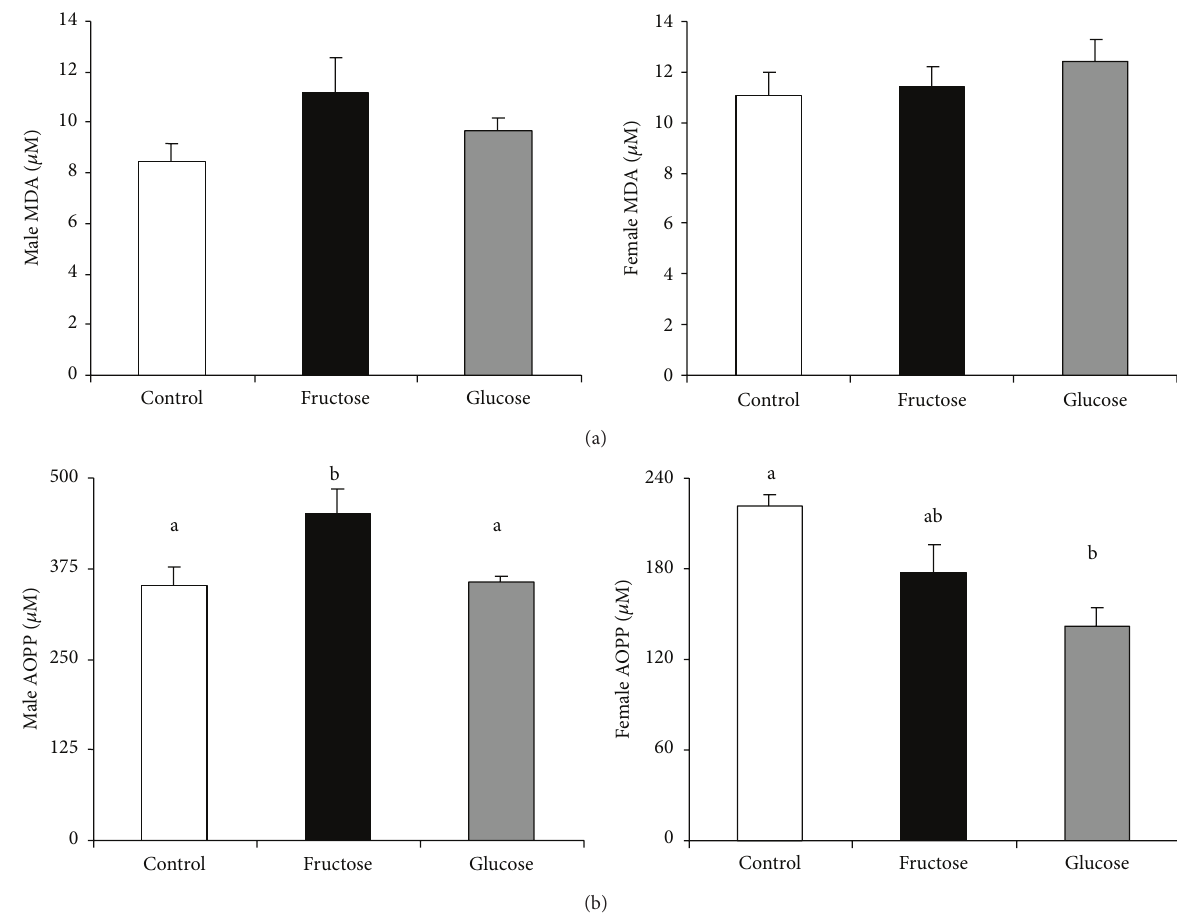
Figure 2: Fructose in pregnancy influences plasma oxidative stress in progeny. Male and female (a) plasma MDA (b) and AOPP values of 90-day-old progeny from control, fructose-fed, and glucose-fed pregnant rats. Data are means ± SE; 𝑛 = 10 –12 animals from four litters. Different letters indicate significant differences between the groups ( 𝑃 < 0.05